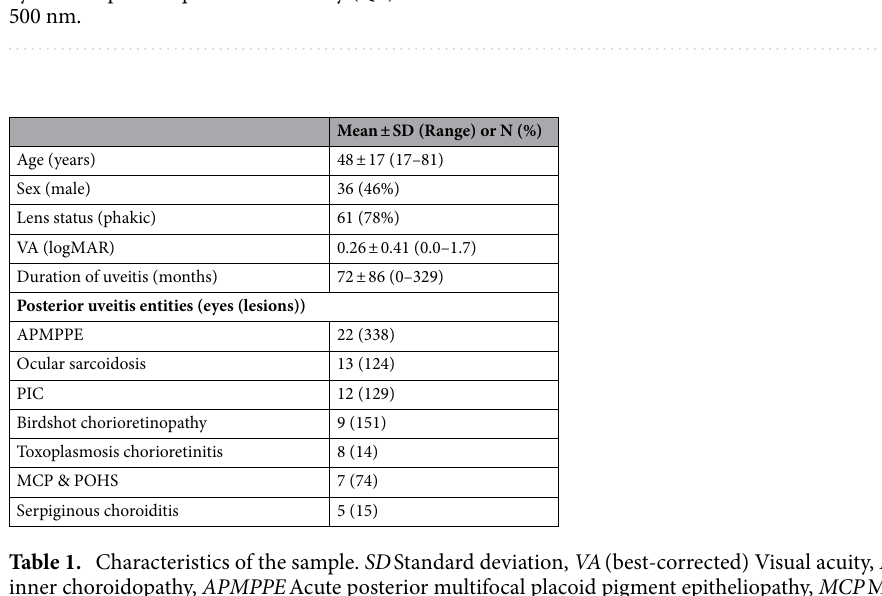
Figure 1. Eidon Autofluorescence sensor quantum efficiency. Each wavelength from 500 to 750 nm contributes to both, green and red channels with different efficiencies. The single-color component (red or green) of a pixel has to be interpreted as the total contribution of all wavelengths collected by the sensor after they are multiplied by their respective quantum efficiency (QE). The dashed line illustrates the barrier filter with the cut-off at 500 nm.